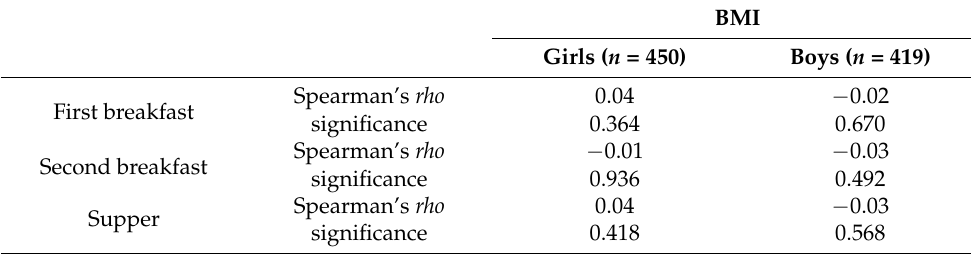
Table 3. The correlation between BMI of boys and girls and the frequency of main meals